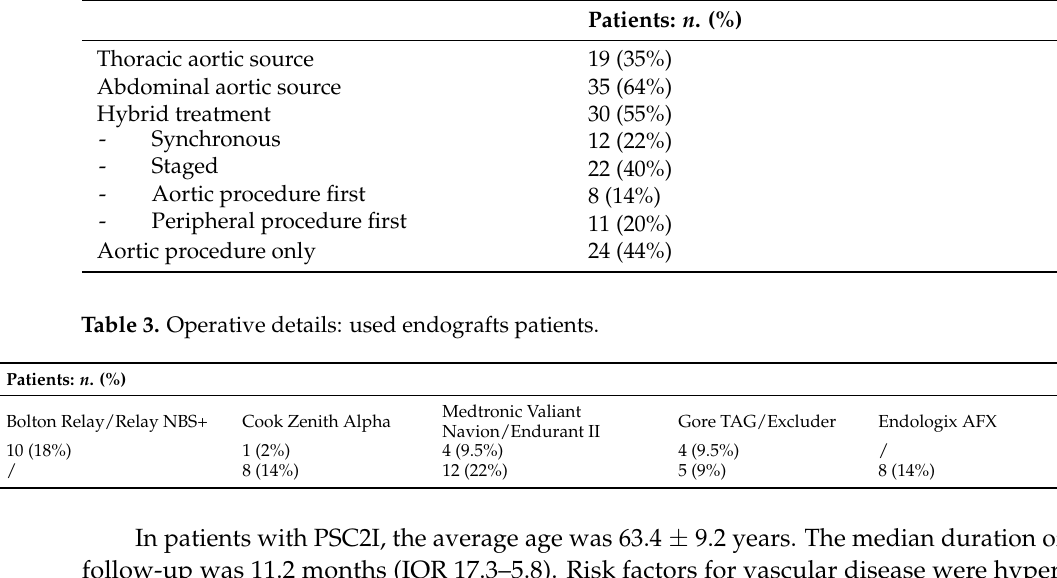
Table 2. Operative details of patients.